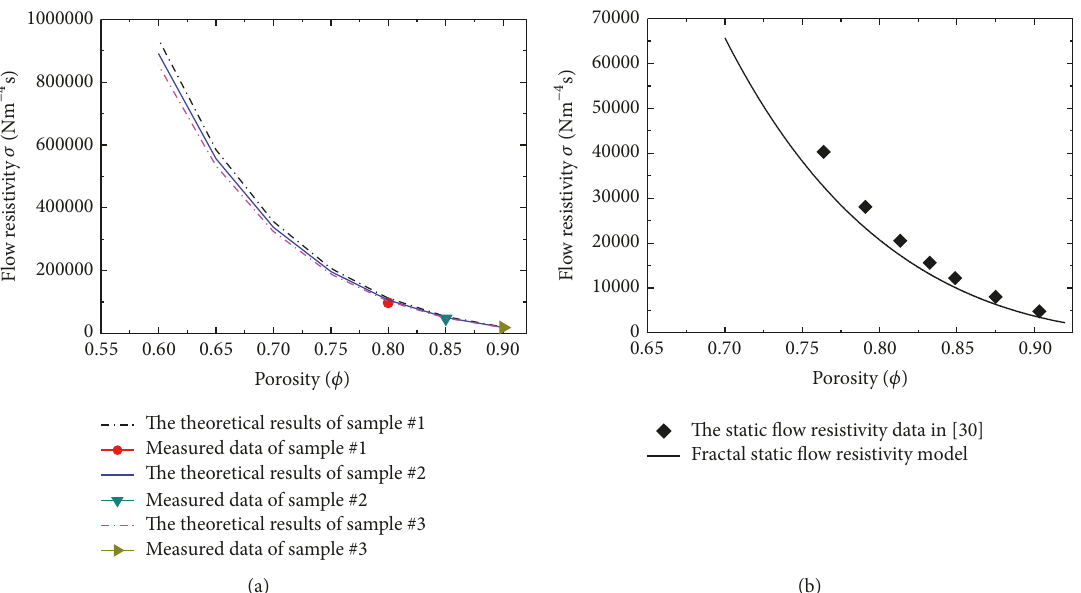
Figure 13: Comparisons between the calculated and experimental results of the static flow resistivity: (a) compared with the test data; (b) compared with the calculated results in